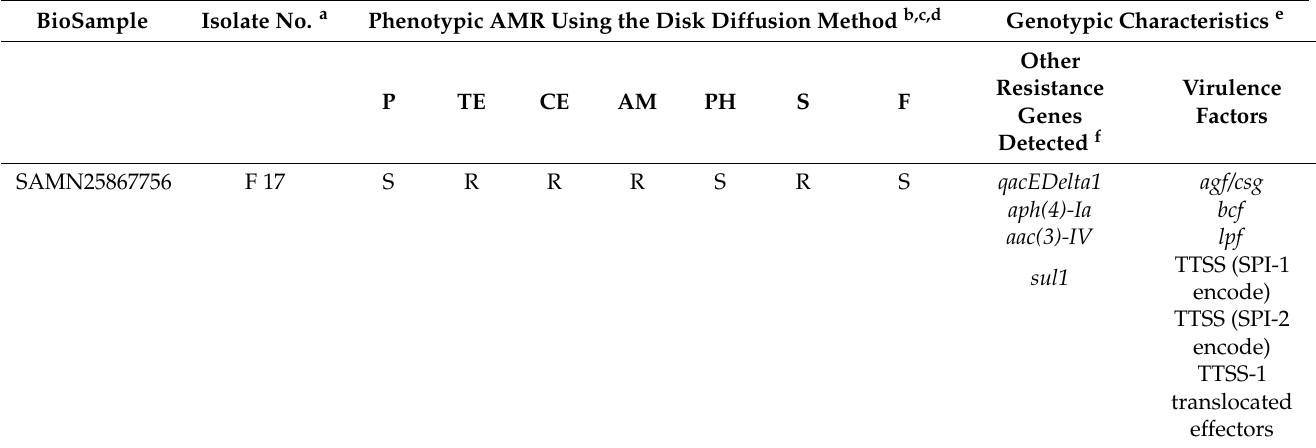
Table 4. Detection of the bla CTX-M-65 gene, other resistance genes, and virulence genes in S. Infantis.